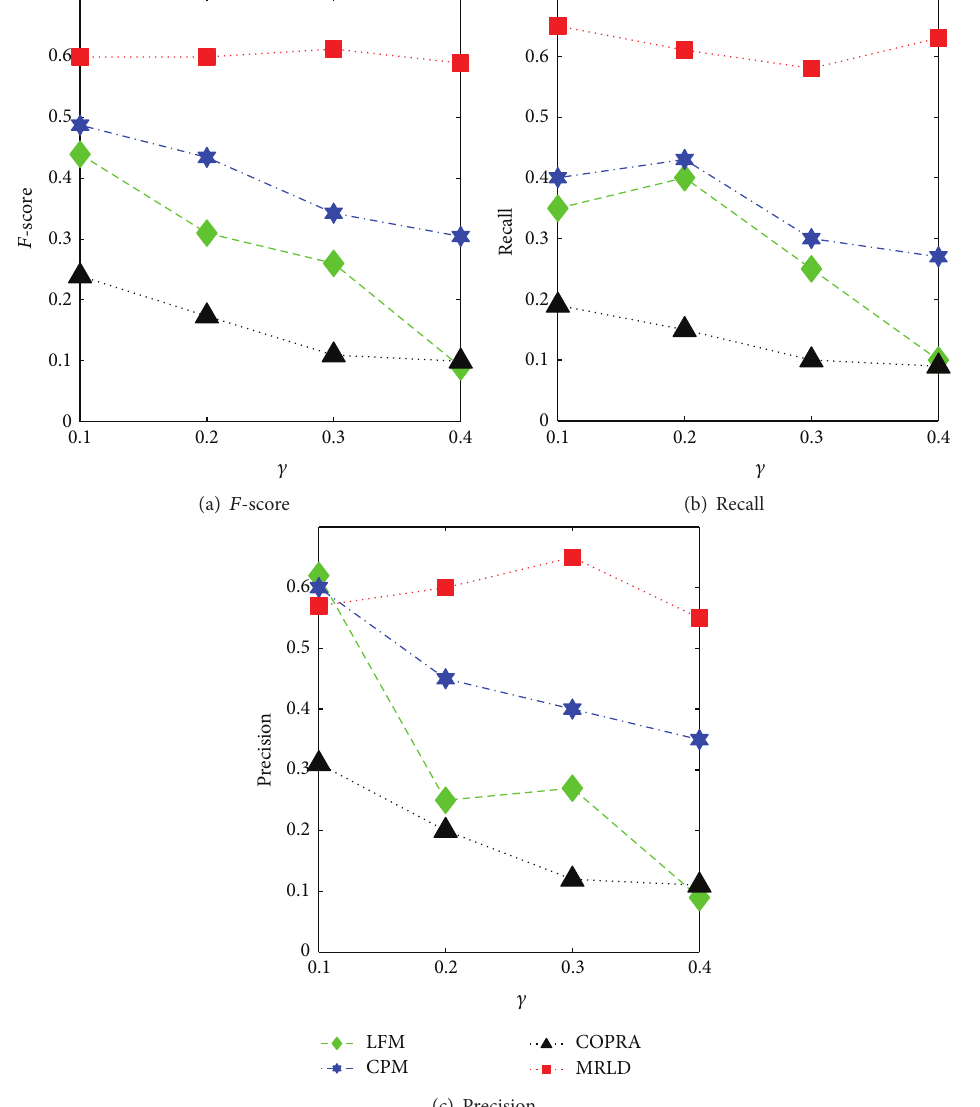
Figure6:ComparisonofMRLDwithotheralgorithmsintermsof 𝐹 -score,recall,andprecisioninhigh-densitynetworks( 𝑂 𝑛 = 100 , 𝑂 𝑚 = 2 ).